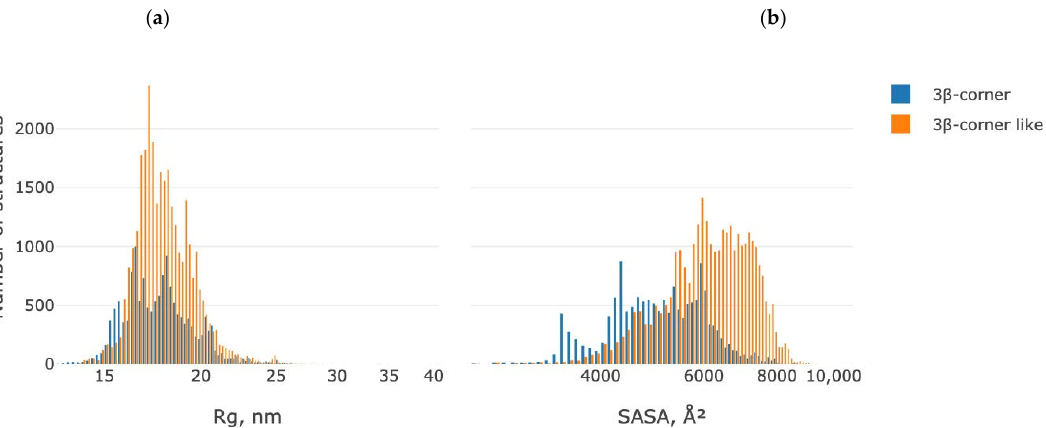
Figure 7. Distribution of gyration radius (Rg, nm) (a) and solvent accessible area (SASA, Å 2 ) values (b) for the dataset under study. Blue— 3 β‐ corner , orange— 3 β‐ corner ‐ like structures. Proteins whose three ‐ dimensional structure contains the studied 3 β‐ corner motif are diverse both in terms of localization in the cell and in terms of their molecular function and belonging to biological processes (Figure 8).